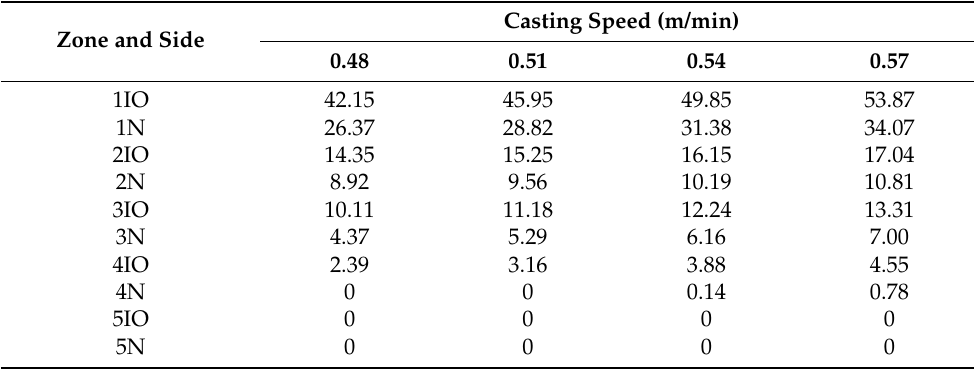
Table 4. Optimized water table for GCr15.